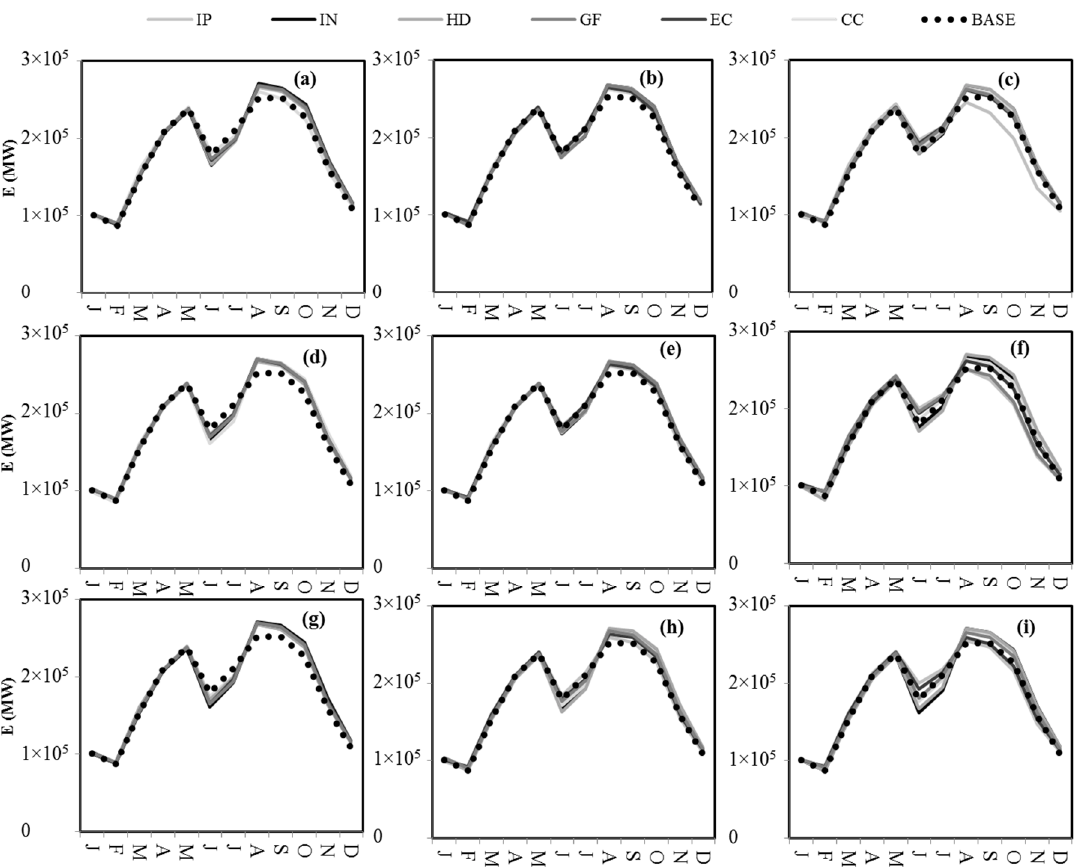
Figure 10. The monthly hydropower generation of the Dez power plant for the base period and under climate change conditions projected by the six GCMs and three SRES scenarios for the 2020s, 2050s, and 2080s time horizons; ( a ): A1B-2020s; ( b ): A2-2020s; ( c ): B1-2020s; ( d ): A1B-2050s; ( e ): A2-2050s; ( f ): B1-2050s; ( g ): A1B-2080s; ( h ): A2-2080s; ( i ): B1-2080s.